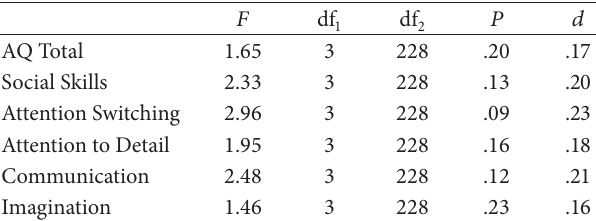
Table 6: ANCOVAs comparing males and females with diagnostic group on scores on the subscales of the AQ controlling for age.